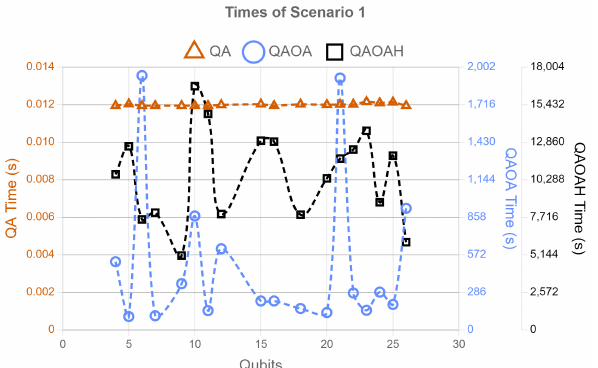
Figure 6. QPU Results QPU Times for Scenario 1 Runs. QA timing includes the anneal time of each 50 samples, 20 microseconds per sample. QAOA and QAOAH varied in the number of jobs that ran, each of which ran the parameterized circuit 1000